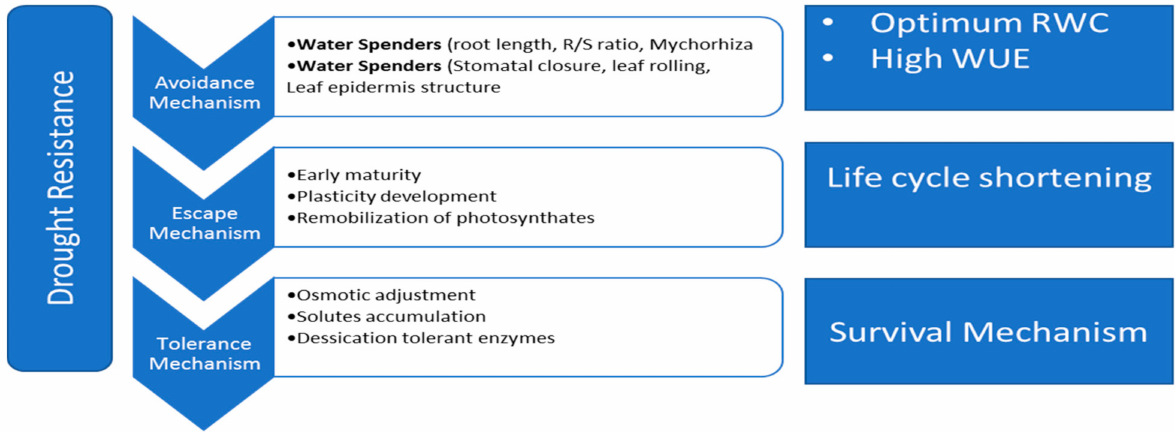
Figure 3. Schematic diagram of drought resistance mechanism in plants. RWC = relative water contents; WUE = water- use